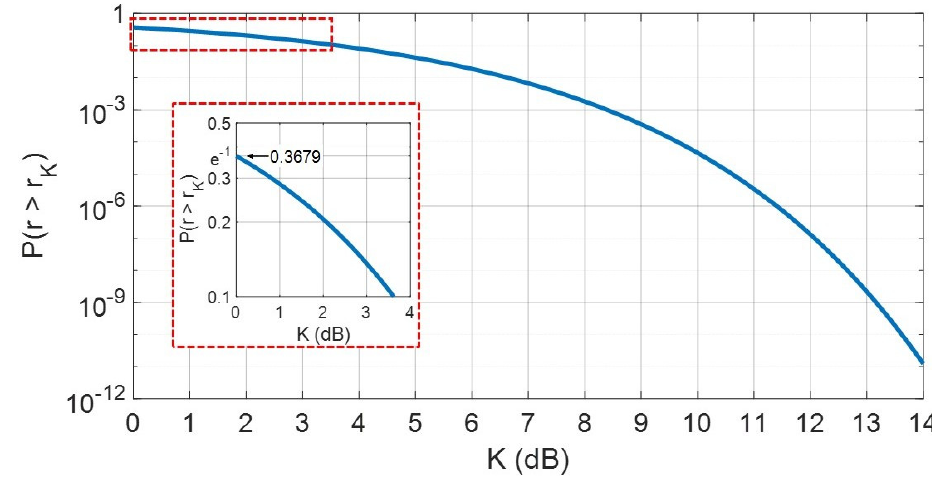
Figure 3. Probability of the event { r > r K } , r K given by Equation (11), versus K in dB.